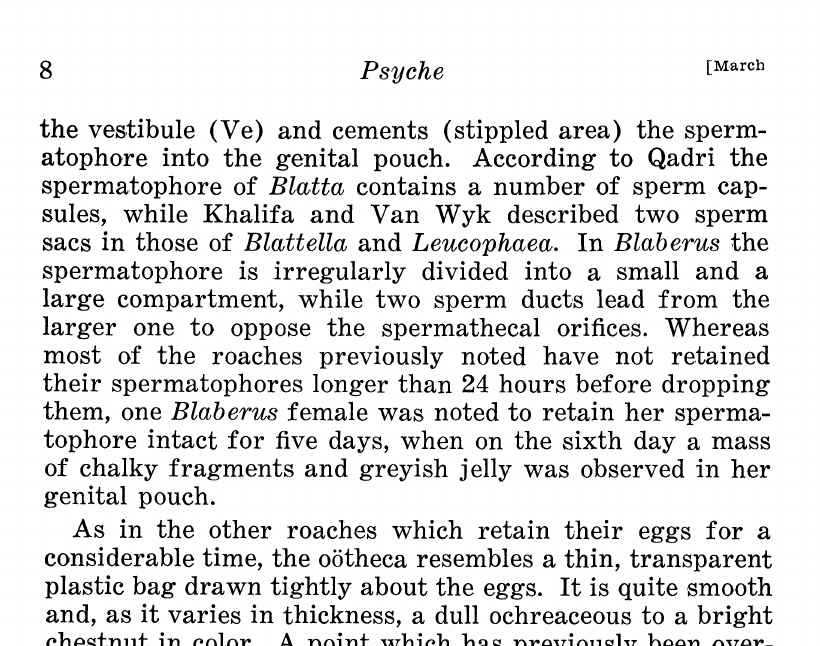
Fig. 1. Blaberus cranii]era Burm. Ventral dissection of female repro- ductive system showing spermatophore (Sph) cemented (stippled area) into the genital pouch over the gonopore. The posterior ventral wall of the genital chamber has been removed. Fig. 2. Sagittal section S, sternite; Sph, spermatophore; T, tergite; Ve, vestibule; Vul,